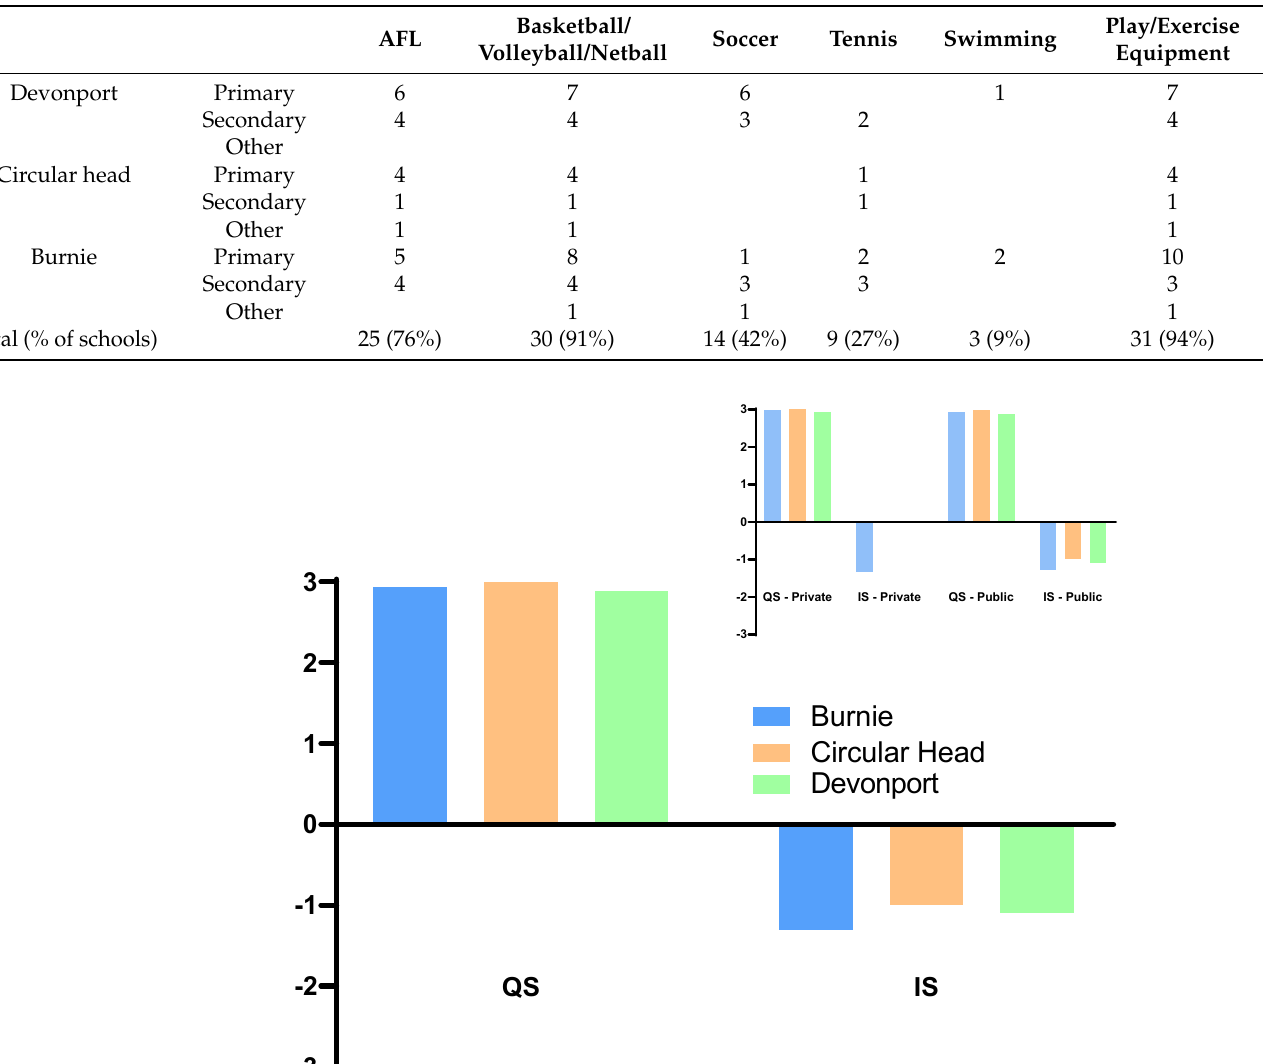
Figure 1. Quality rating for physical activity infrastructure of all schools (main figure) and public and private schools (inset) in Burnie, Devonport, and Circular Head. Inter-rater reliability Cronbach’s alpha values were 0.991, 0.935, and 0.982 for Devonport, Circular Head, and Burnie, respectively. ‘Quality’ of infrastructure was objectified as follows: 3—good, 2—mediocre, or 1—poor; ‘Incivility’ associated with infrastructure was objectified as follows: 3—high, 2—medium, or 1—low.